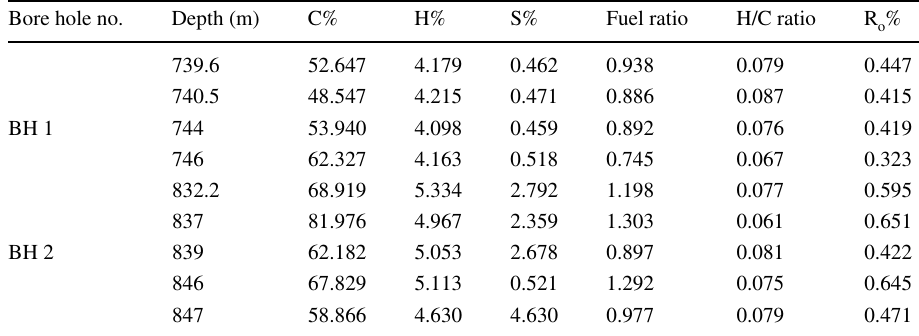
analysis and other parameters of coal samples